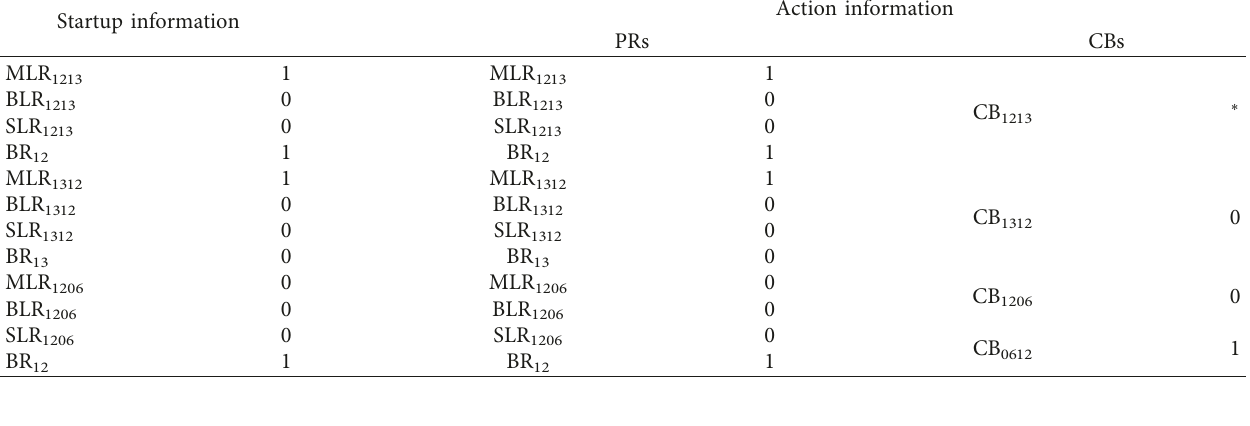
Table 5: Start and action information of protective devices for case 4. Startup